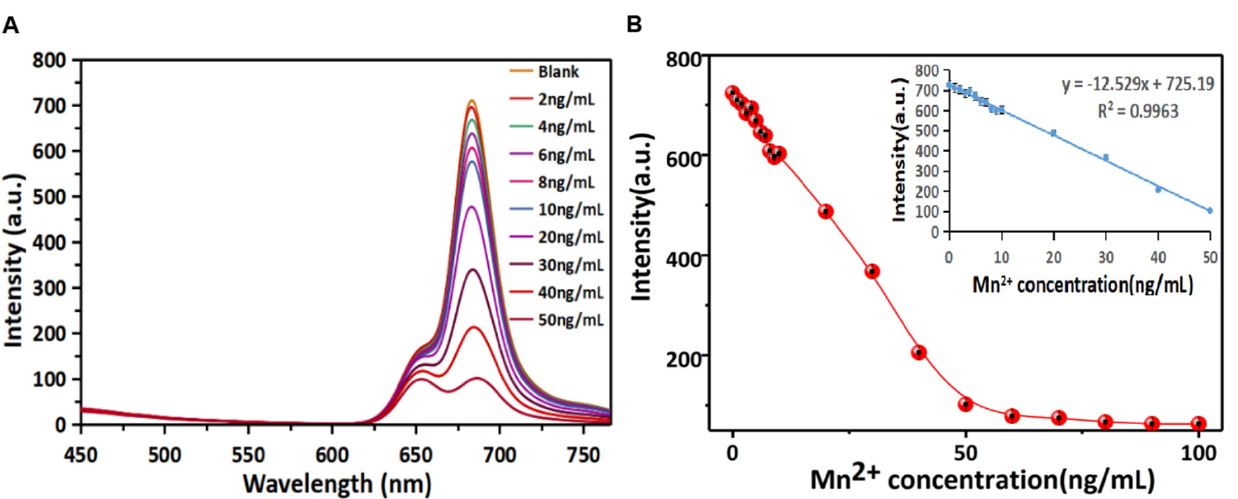
Figure 5. Fluorescence responses of the R-CDs upon the addition of different concentrations of Mn 2+ ( A ) and the linear correlation of fluorescence intensity versus the concentrations of Mn 2+ in the range from 0 ng/mL to 100 ng/mL ( B ).